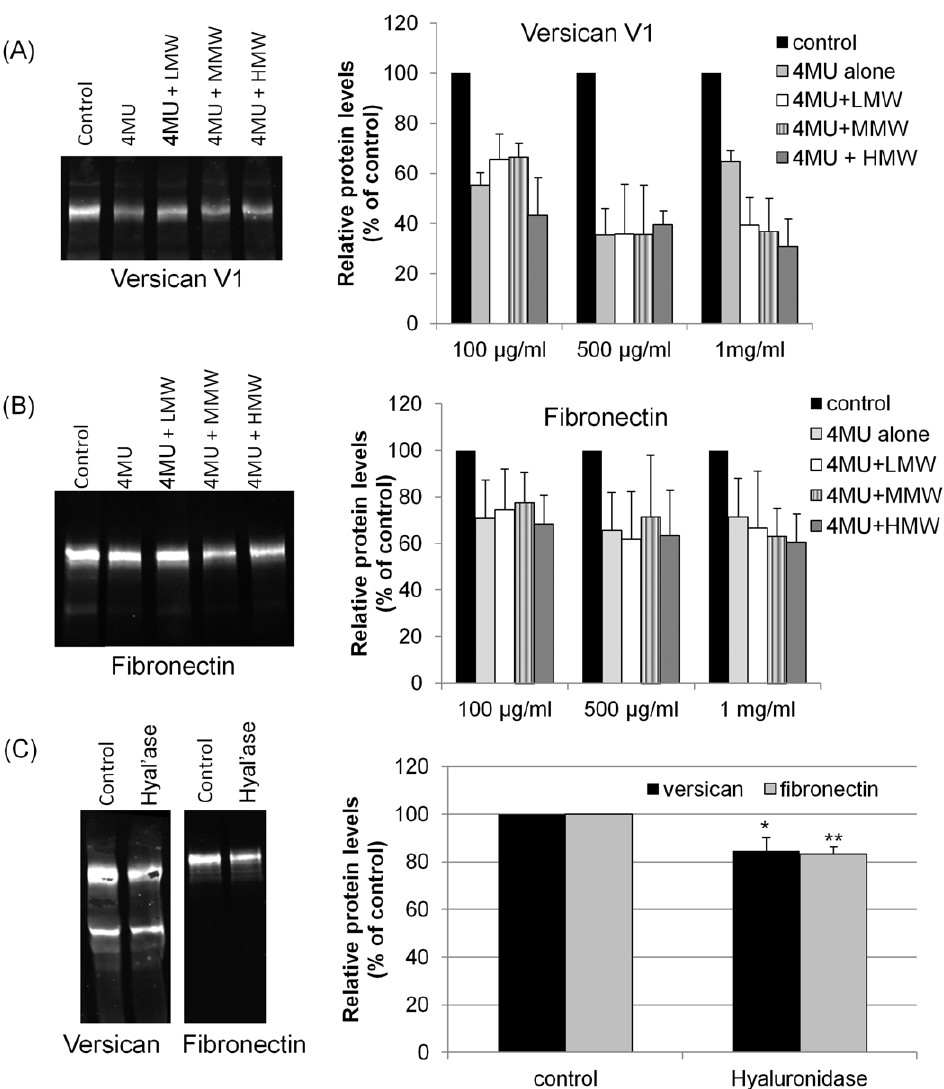
Figure 5. Effect of addition of exogenous HA and hyaluronidase treatment. Confluent TM cells were treated for 2 days with 1 mM 4MU and then HA of different molecular weights (high MW=1.5 MDa; medium MW=700 kDa; low MW=40 kDa) was exogenously added for a further 3 days. Versican and fibronectin protein levels in conditioned media were assessed by Western immunoblot. (A) Versican V1 isoform and (B) fibronectin protein levels are significantly decreased by 4MU treatment in all cases, but addition of 3 concentrations (100 m g/ml, 500 m g/ml and 1 mg/ml) of HA of HMW, MMW and LMW did not significantly alter levels compared to 4MU treatment alone. The Western immunoblots show data from a 500 m g/ml treatment. All lanes were from adjacent lanes of the same immunoblot. Error bars are the s.e.m.; n=3. (C) Hyaluronidase (1.5 m g/ml; 1 unit) was added to confluent TM cells in serum-free media each day for 3 days. Western immunoblots and densitometry showed that versican V1 and fibronectin protein levels were significantly decreased by hyaluronidase treatment. All lanes were from adjacent lanes of a single immunoblot. Versican and fibronectin values were normalized to total protein loaded and are presented as a percentage of the control. Error bars are the s.e.m.; n=4; * p=0.03 and ** p=0.001 by one-way